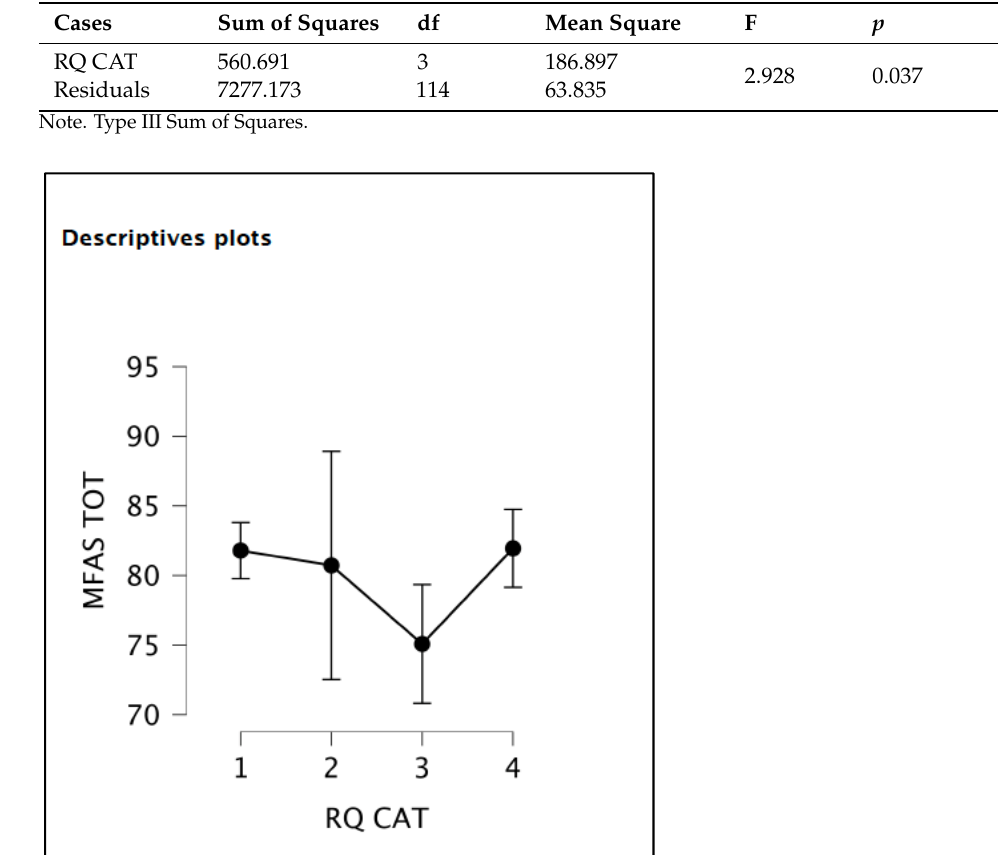
Table 3. ANOVA test, total MFAS versus categorial RQ.